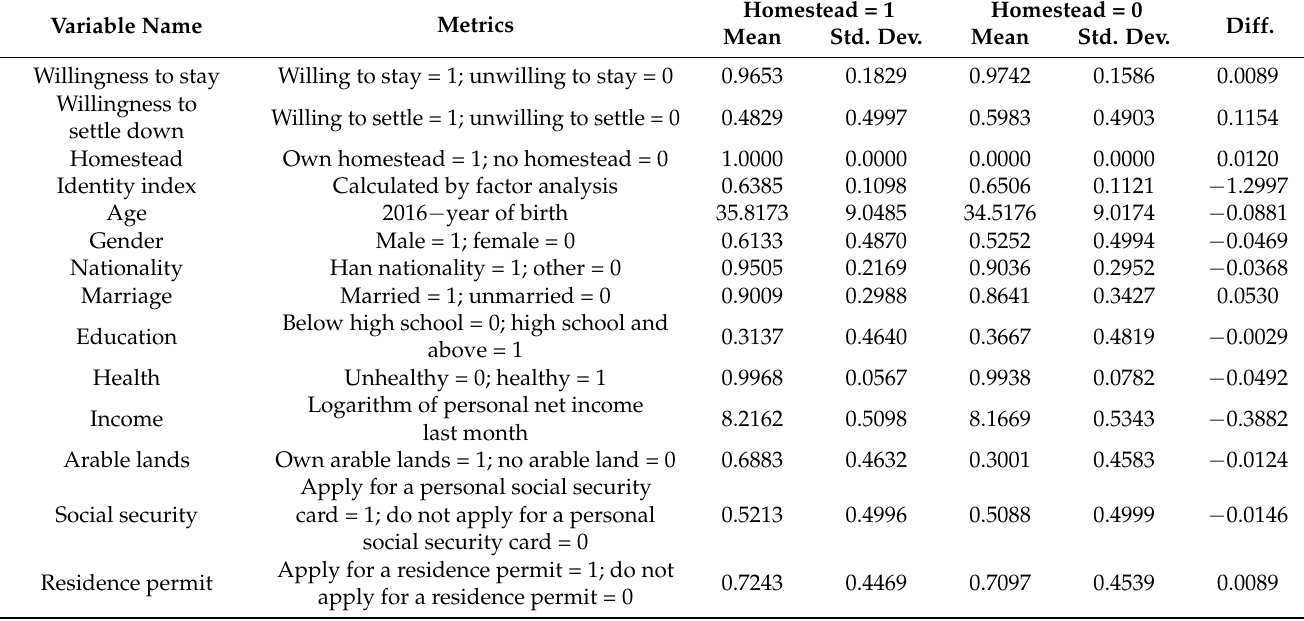
Table 2. Variable meaning and descriptive